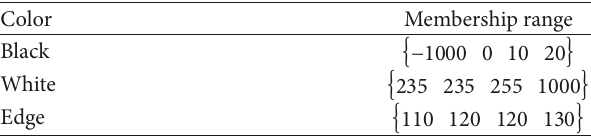
Table 2: Initial output membership functions.